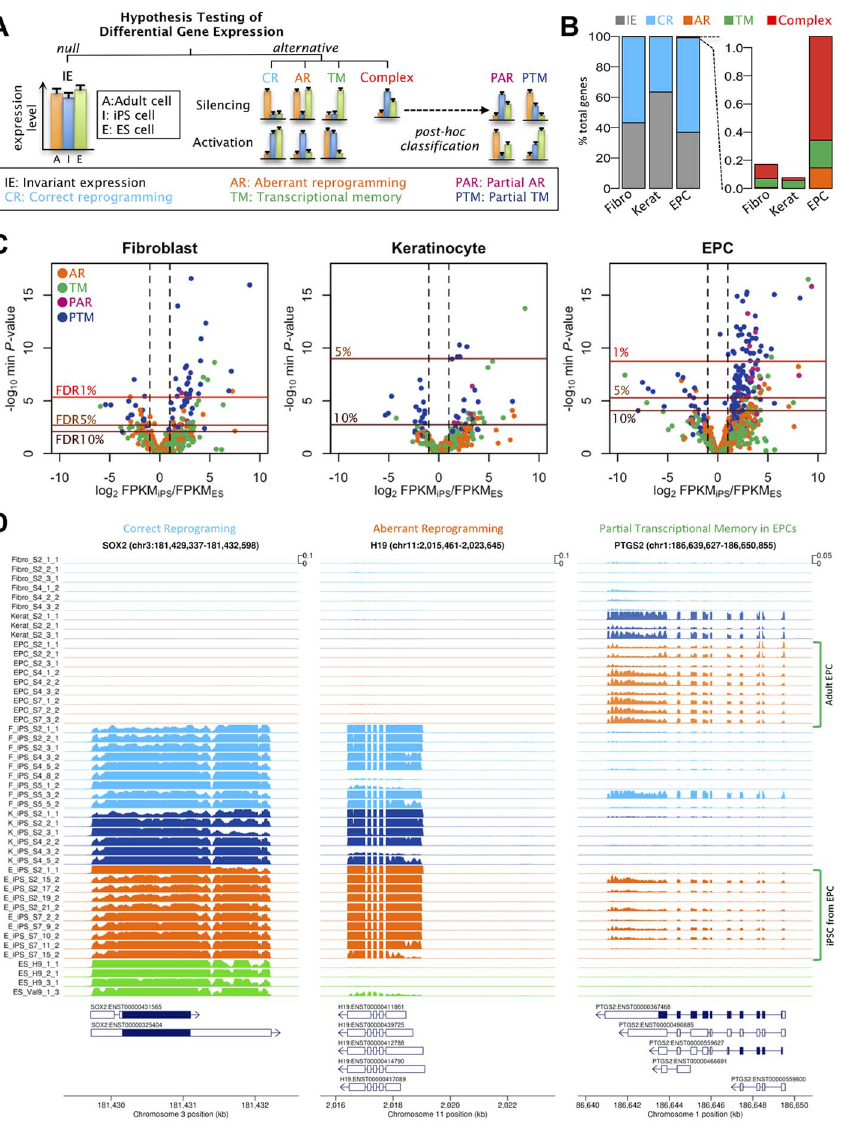
Figure 2. Effects of cell type and tissues of origin on expression levels in iPSCs. (a) Schematic of hypothesis testing approach to identify genes with invariant expression (IE) from genes that we defined as correctly reprogrammed (CR), aberrantly reprogrammed (AR), with transcriptional memory (TM) and showing complex expression. Genes showing complex expression are further classified into partial AR (PAR) and partial TM (PTM) according to the expression patterns. (b) Percentages of genes assigned to alternative differential expression groups based on a hierarchical model (see Text S1 1.4.3). (c) Volcano plots of differentially expressed genes. Plots show log 10 of minimum P-values among the four alternative hypotheses against log 2 fold change of average expression levels between iPSCs and ESCs. The colours of points indicate the differential expression categories into which a gene was classified. Dashed lines show twofold enrichment of mean expression levels between iPSCs and ESCs. FDR thresholds were calculated by permutation. (d) Read coverage depth in three examples of differentially expressed genes; SOX2, was categorised as correctly reprogrammed in all three tissues (F-iPSCs: p , 1 6 10 2 24 ; K-iPSCs: p , 1.2 6 10 2 16 ;E-iPSCs: p , 4.6 6 10 2 25 ), H19 was categorised as aberrantly reprogrammed in all three tissues (F-iPSCs: p , 1.2 6 10 2 6 ; K-iPSCs: p , 2.7 6 10 2 4 ;E-iPSCs: p , 1.5 6 10 2 16 ) and TYW3 gene was categorised as partial transcriptional memory in E-iPSCs (p , 7.1 6 10 2 8 ), invariant expression in F-iPSCs (p . 0.1) and correctly reprogrammed in K-iPSCs (p , 1.4 6 10 2 3 ). Coverage depth was truncated at 1000 reads per bp.